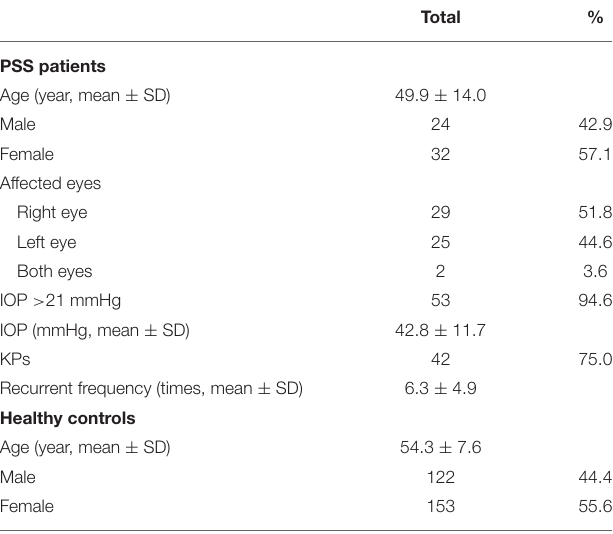
TABLE 1 | The demographic and clinical features of the PSS cases and